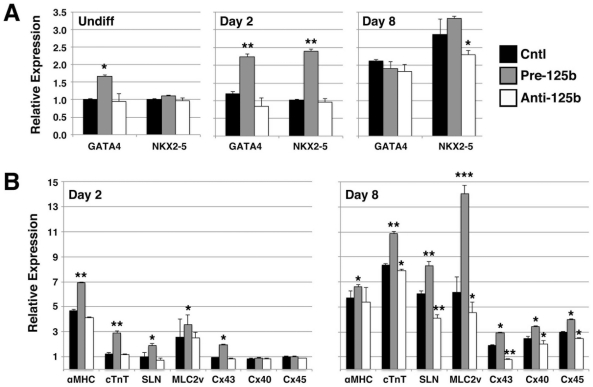
miR-125b promotes the expression of cardiac-specific genes during hESC differentiation.hESCs were transfected with pre-miR-125b (pre-125b) or anti-miR-125b inhibitor (anti-125b), cultured in differentiation medium for 2 or 8 days, and analyzed for expression of cardiac-specific mRNAs by qPCR. A) Overexpression of pre-125b induced premature expression of the early cardiac transcription factor, GATA4, in undifferentiated hESCs (Undiff), and promoted the early expression of both GATA4 and Nkx2-5 in hESCs cultured in differentiation medium for only 2 days, before the usually observed expression of these transcription factors during CM differentiation. Anti-125b suppressed the expression of Nkx2-5 at day 8 of differentiation, but had little effect on GATA4 at this time point. Data shown are mean±s.e.m. (N = 3). *, p<0.05; **, p<0.01. B) Overexpression of pre-125b resulted in the early expression of CM structural genes at day 2, before they are usually observed, while expression of anti-125b inhibited the expression of these genes at day 8, when they begin to be expressed in differentiating hESCs. αMHC, α-myosin heavy chain; cTnT, cardiac troponin T; SLN, sarcolipin; MLC2v, ventricular myosin light chain 2; Cx, connexin. Data shown are mean±s.e.m. (N = 3). *, p<0.05; **, p<0.01; ***, p<0.001.